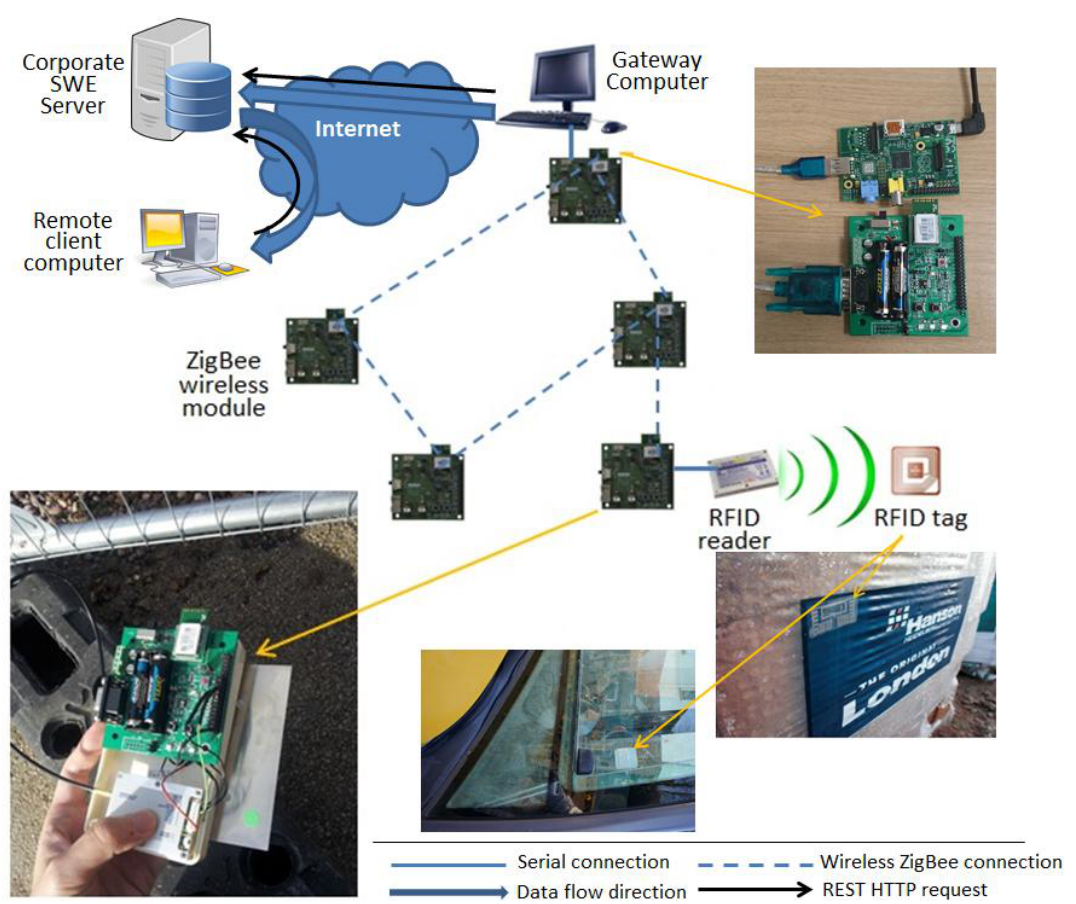
Figure 5. Demonstration system structure and